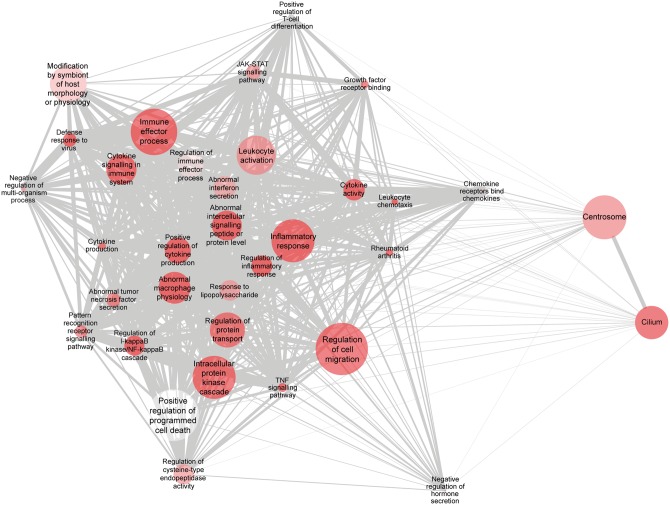
Functional gene sets associated with innate immunity and inflammation are enriched in resting HD monocytes. GSEA identified biologically relevant gene sets that are enriched in resting HD monocytes. A network diagram of significant biological themes among the upregulated genes is shown, indicating number of genes (node size), statistical significance (darkest shading = lowest P-value) and gene content similarity via the Jaccard coefficient (edge thickness). Nodes with similar gene content cluster more closely due to an edge-weighted layout (modified for readability). An FDR cut-off of < 0.05 was used to determine gene set inclusion in the diagram, before the Jaccard coefficient was used to filter out gene sets with similar gene content. The diagram was rendered in Cytoscape 3.3.0.